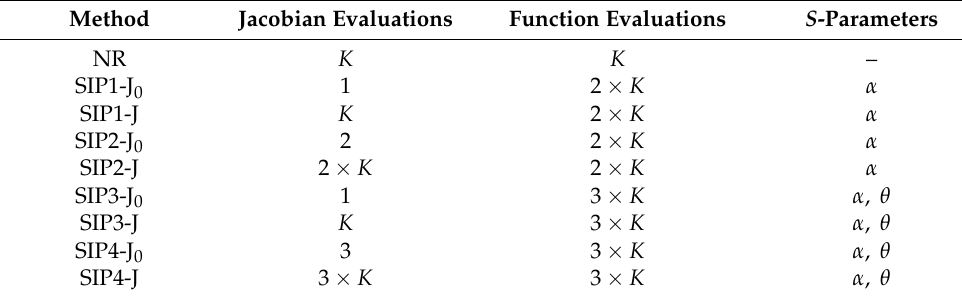
Table 1. Main features of the studied PF solution methods.